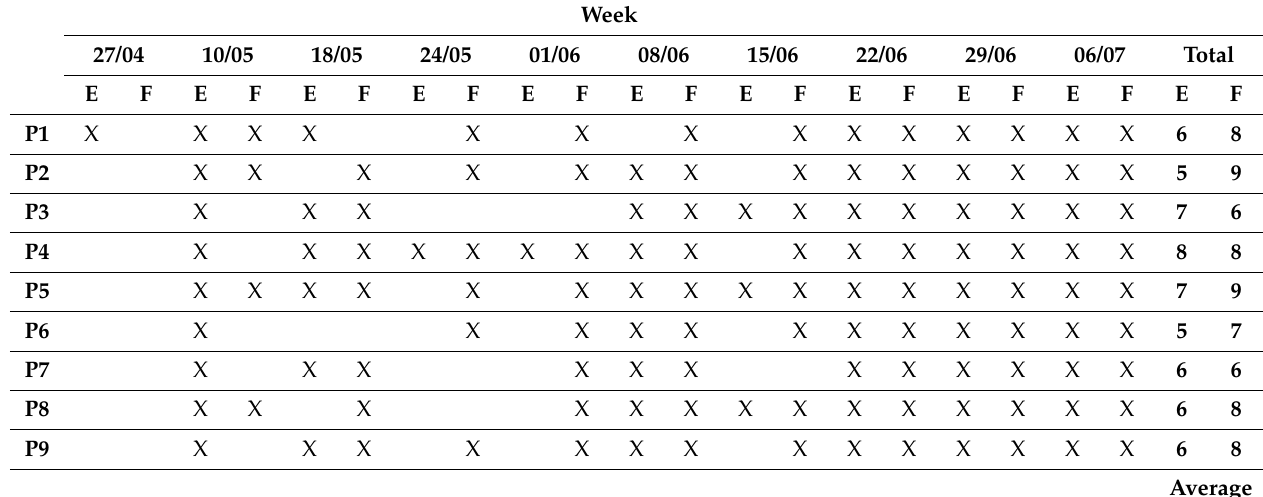
Figure 9. Levels of infection risk signalled by the EPI model. Coloured arrows indicate a different level of infection risk: red indicates a high infection risk, yellow indicates a medium infection risk; and green indicate a low infection risk. The stars indicate the moments when the first symptoms appeared in a field. Table 4. Dates of spray applications and total number of treatments performed for powdery mildew control in EPI (E) and farmers’ (F) plots of the nine vineyards during 2021. Different letters indicate significant differences among samples ( p <